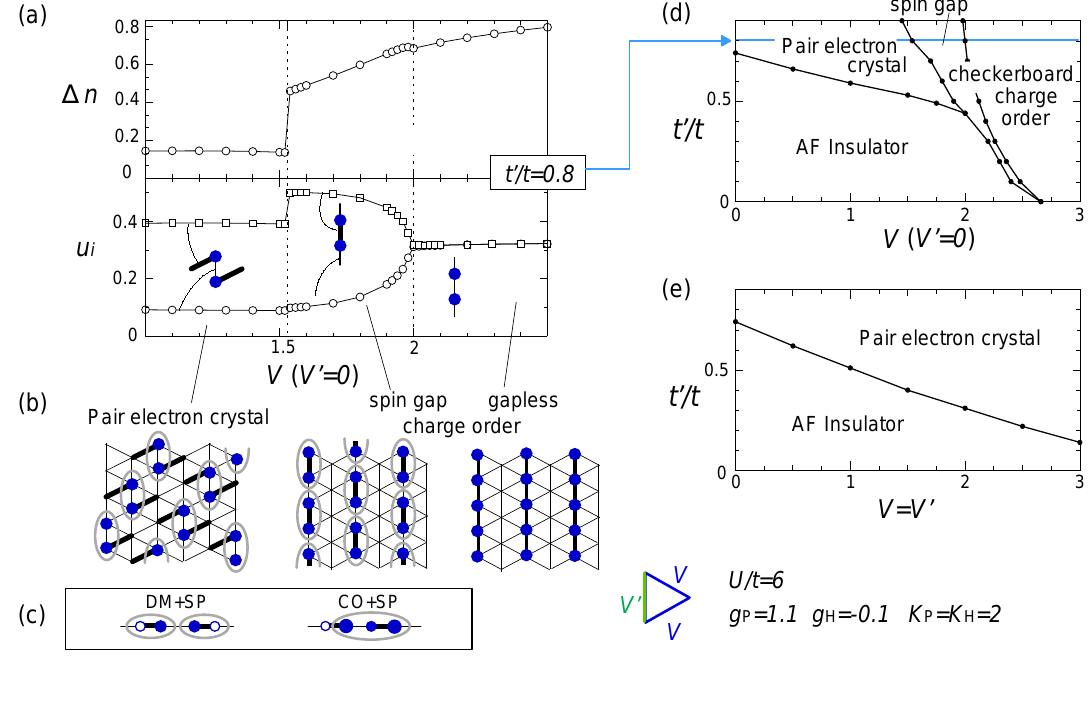
Figure 19. Exact diagonalization results by Dayal et al . [79] on the quarter-filled extended Hubbard plus the Holstein and Peierls-model for N = 4 × 4 anisotropic triangular lattice =1 . 1 (square type along V -bonds), g =0 . 1 , and K = K =2 . ( a ) Charge with U/t =6 , g P H P H − 0 . 5 and the degree of lattice modulation u disproportionation ∆ n = n at V (cid:48) = 0 i i (square lattice) as functions of V (along t (cid:48) /t = 0 . 8 in ( d )); ( b ) Pair-electron crystal and charge orders with and without spin gap; ( c ) DM + SP and CO + SP states studied by Otsuka et al . [80] to be compared with the pair electron crystal and the spin-gapped charge order; ( d , e ) Comparison of phase diagrams of square- V ( V (cid:48) = 0 ) and triangular- V = V (cid:48) on the planes of V and t (cid:48) /t ; ( a , d , e ) adapted with permission from [79], copyrighted by the American Physical